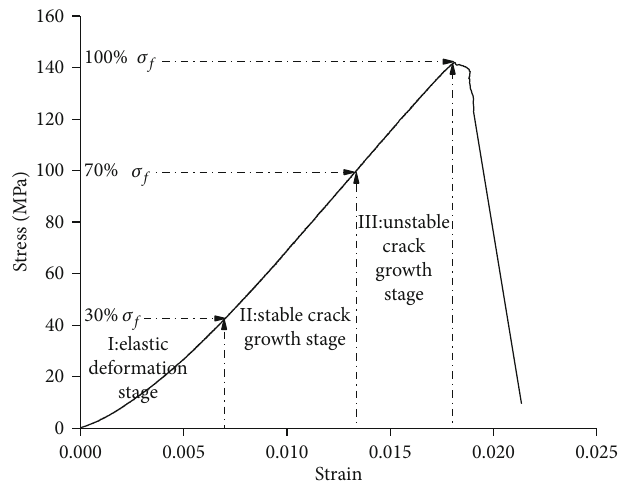
Figure 7: Uniaxial stress-strain curve.